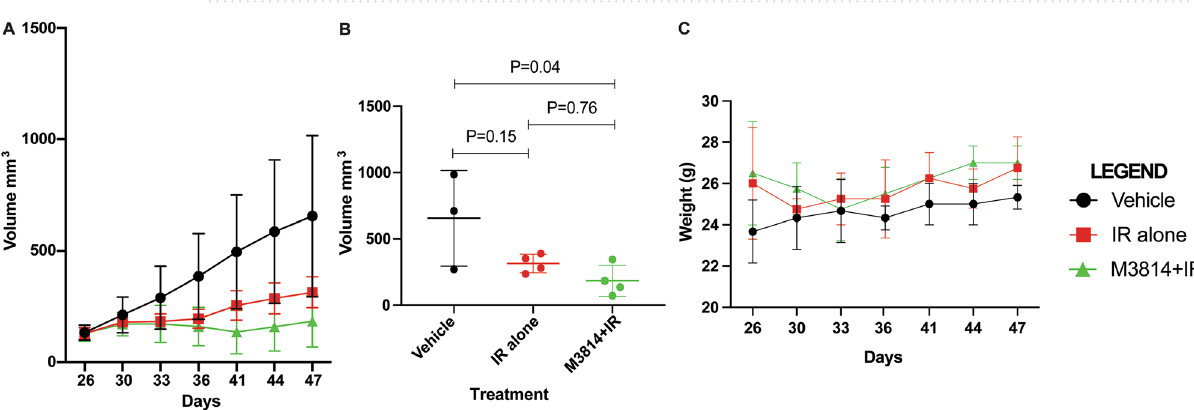
Figure 2. Xenograft experiments were performed with HeLa cell lines in athymic nude mice. Treatment was started 26 days after HeLa cell implantation. Three groups were investigated: vehicle alone (n = 3), IR alone (n = 4), or M3814 in combination with IR (n = 4). Tumor volume was measured twice weekly. ( A ) shows mean tumor volume of each group over the course of treatment. ( B ) shows average tumor volume at treatment endpoint (day 47), t tests were done to compare the treatment groups. ( C ) shows mouse weights during the course of